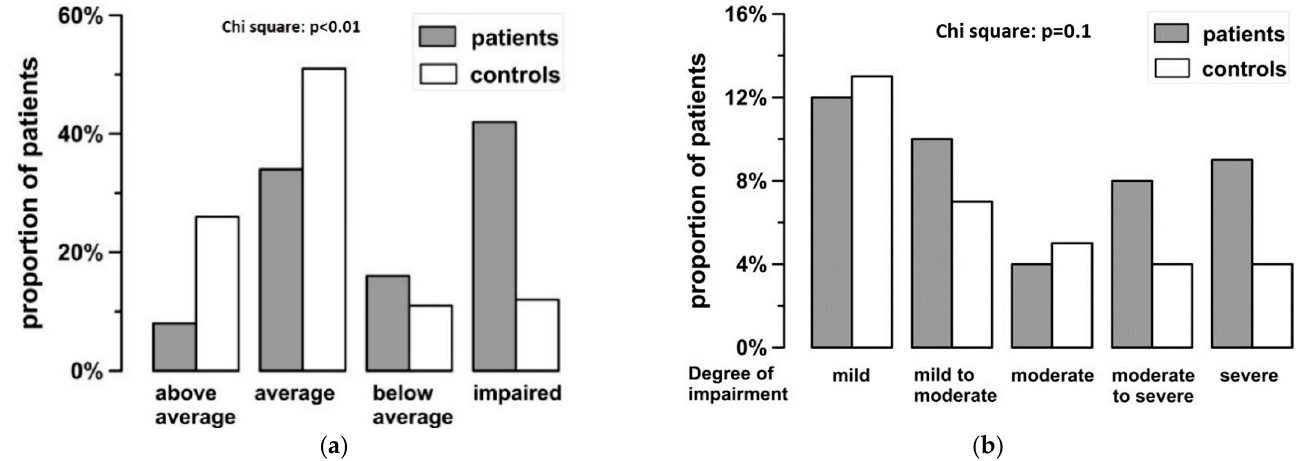
Figure 1. ( a ) Results of CCTT2 are classified into categories according to their Standard Score [21]. Standard Score ≥ 107 equals above average performance, while Standard Scores of 92–106 and 85–91 are classed as average and below average respectively. Standard Scores below 85 are classed as “impaired”. Shaded bars depict patients, white bars depict controls. ( b ) “Impairment” can be further differentiated by Standard Score: 77–84 mildly impaired, 70–76 mild-to-moderately impaired, 62–69 moderately impaired, 55–61 moderately-to-severely impaired, 0–54 severely impaired. Shaded bars depict patients, white bars depict controls.